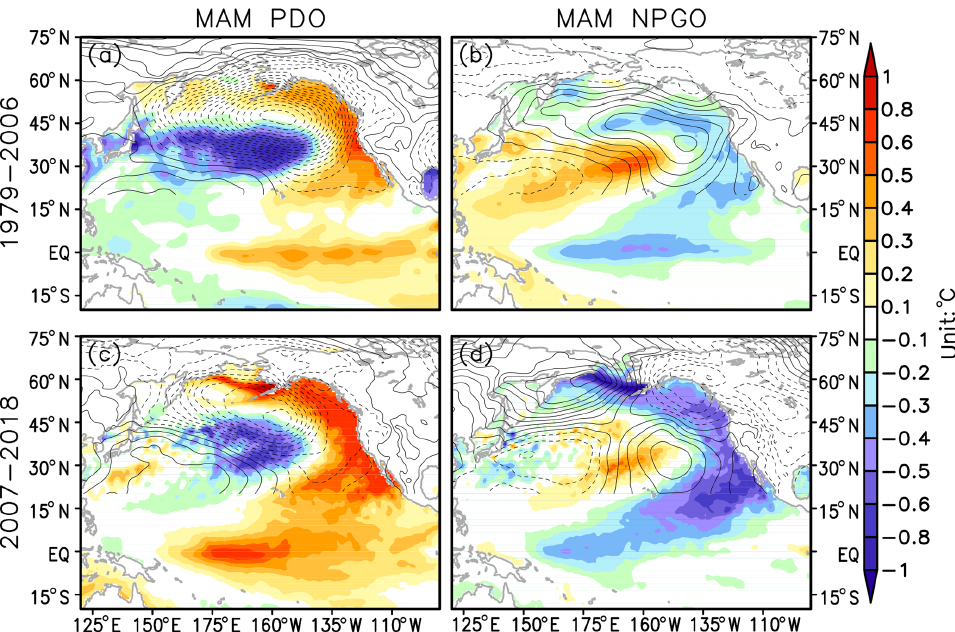
Figure 6. (a) Regression of March–May mean sea surface temperature anomalies (color shading) and sea level pressure anomalies (contour) on the PDO index during the period of 1979–2006. The solid and dashed contours indicate the positive and negative anomalies of SLP. The contour interval is 0.2hPa. (b) Same as (a) , but regression on the NPGO index. (c, d ) Same as (a, b) , but during the period of